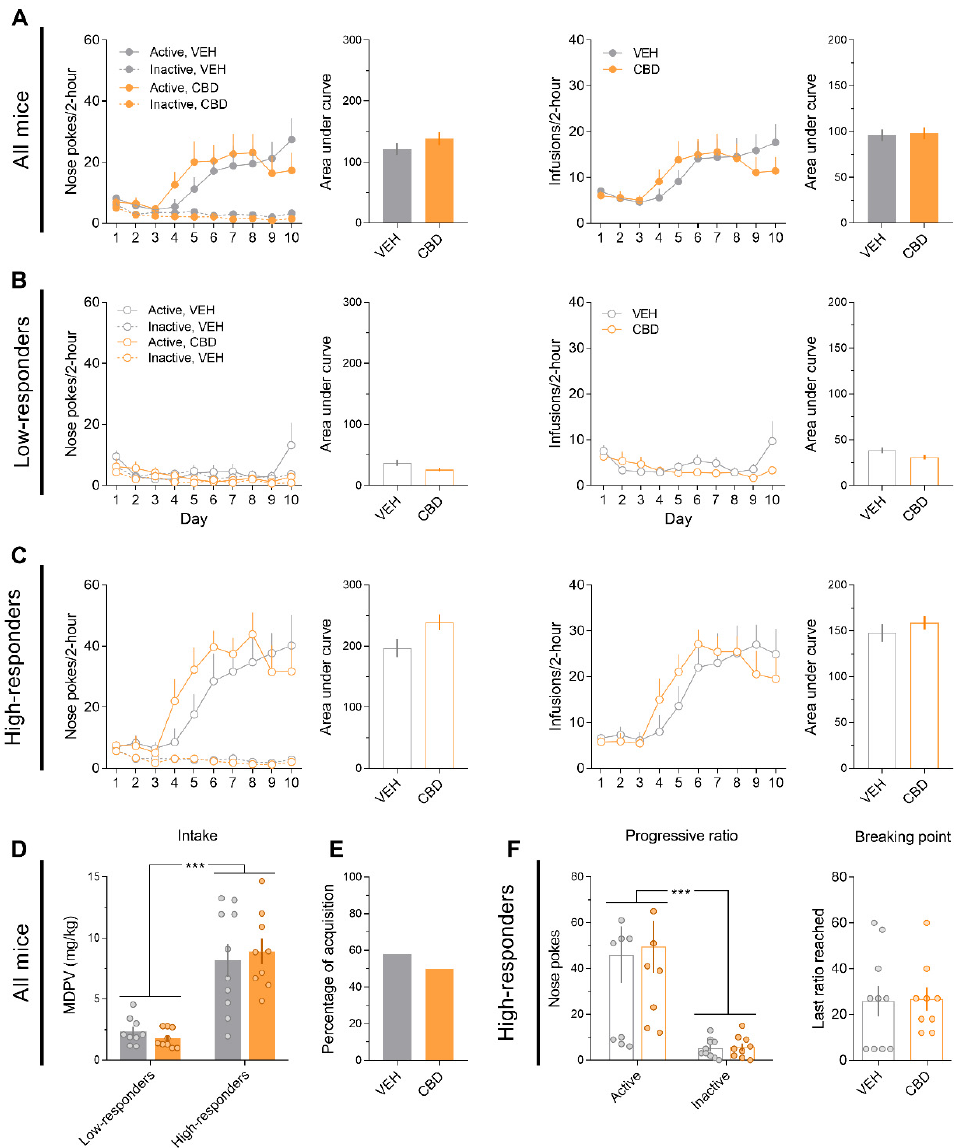
Figure 2. CBD does not modify MDPV (0.05 mg/kg/infusion) self-administration. ( A ) Nose pokes and infusions along the self-administration days and their respective areas under the curve (VEH, n = 19; CBD, n = 18). ( B ) Nose pokes and infusions along the self-administration days and their respective areas under the curve for low-responders (VEH, n = 9; CBD, n = 9). ( C ) Nose pokes and infusions along the self-administration days and their respective areas under the curve for high-responders (VEH, n = 10; CBD, n = 9). ( D ) Total MDPV intake. Two-way ANOVA, *** p < 0.001. ( E ) Percentage of acquisition. ( F ) Active/inactive nose pokes and breaking point during the progressive ratio test. Two-way ANOVA, *** p < 0.001.